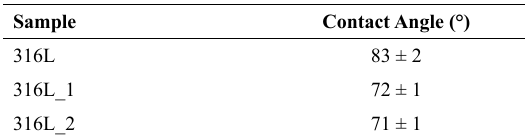
Table 2. Results of contact angle of the surface obtained through wettability.